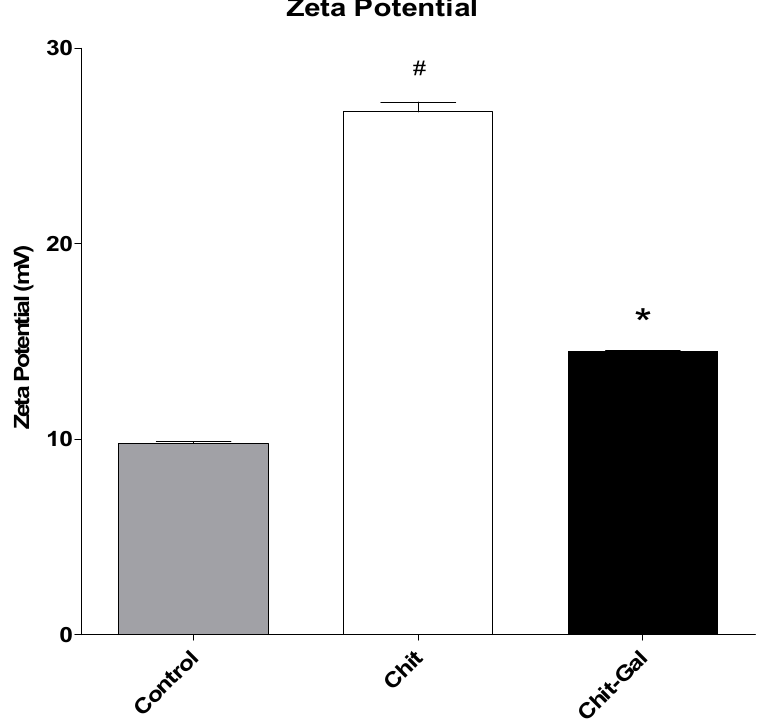
Figure 5. Zeta potential of the crystals formed in the presence of different chitosans. Different symbols indicate a significant difference ( p < 0.05).